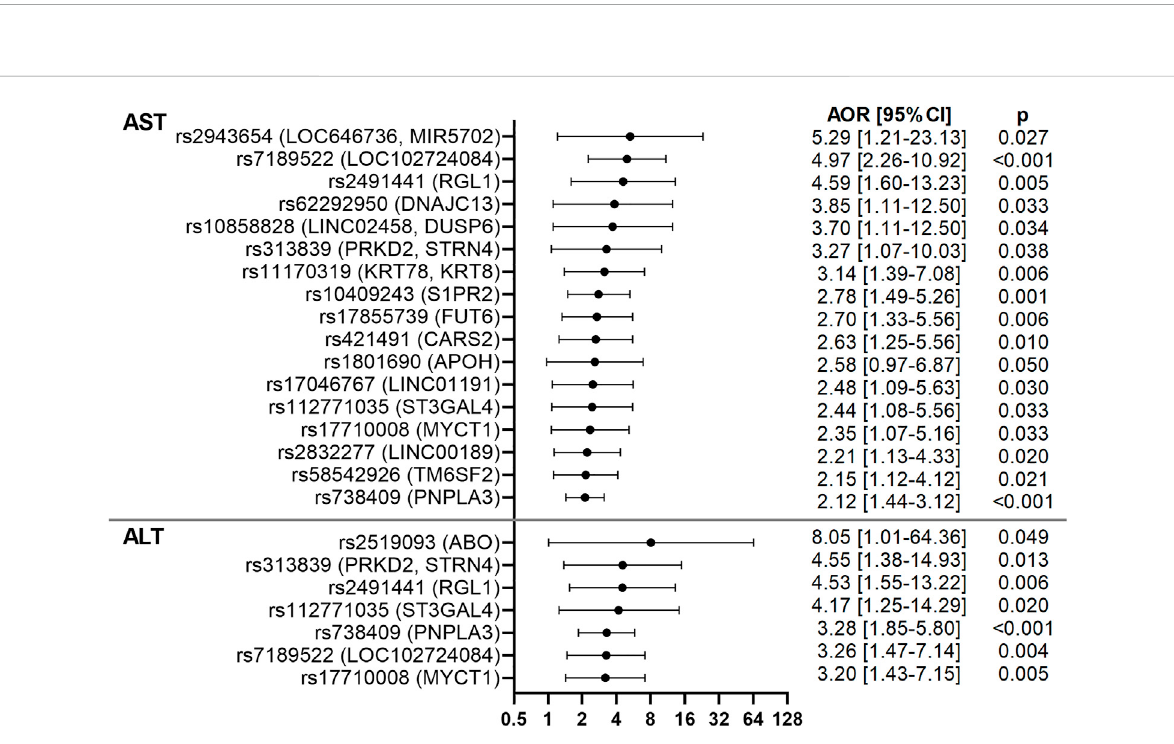
FIGURE 3 ForestplotsofAST-andALT-associatedvariantsintheCCHC.ForestplotsshowAORs[95%CI]forelevatedASTandALT,afteradjustingforage and gender. The top variants associated with AST and ALT are